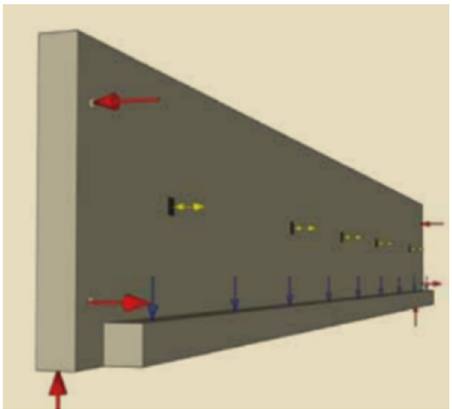
Figure 1: L - shaped slender spandrel [ 1 ] .